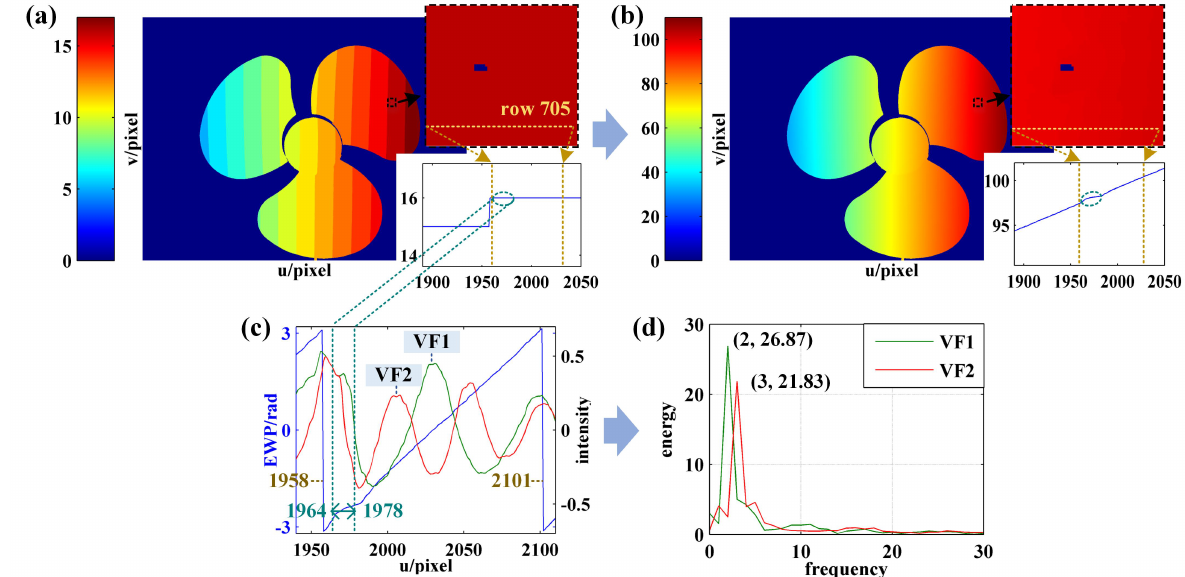
Figure 19. Phase unwrapping results of the three-blade fan obtained using the proposed method: ( a ) fringe order map; ( b ) absolute phase map; ( c ) EWP and coded fringes of row 705; ( d ) FFT spectrum of coded fringes in pixel interval [1958 2101] of row